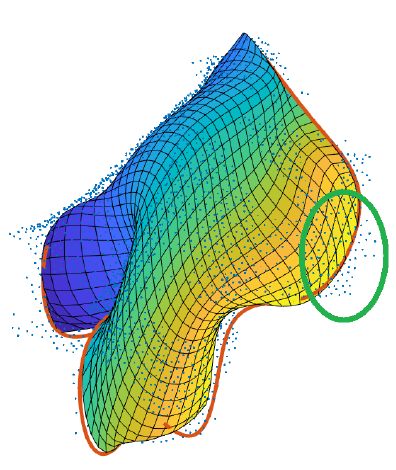
Figure 14. Cropping of a leaf’s area due to the estimated boundary